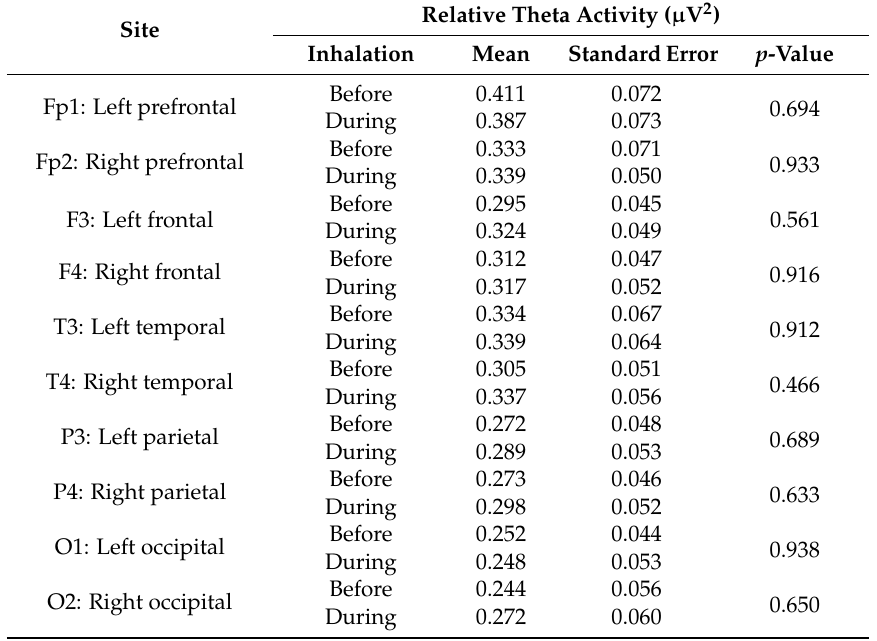
Table 3. Effect of inhalation of volatile organic chemicals (VOCs) from Chrysanthemum indicum Linn é on relative theta